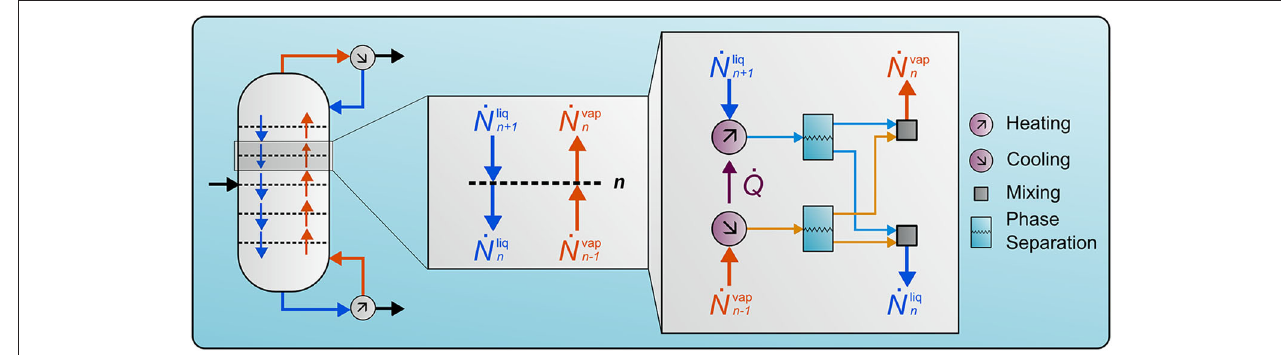
FIGURE 1 | Representation of the overall distillation process as a sequence of elementary processes mixing (gray), heating/cooling (magenta), and phase separation (cyan) as well as single tray fluxes. Adapted from Schack et al. (2019).